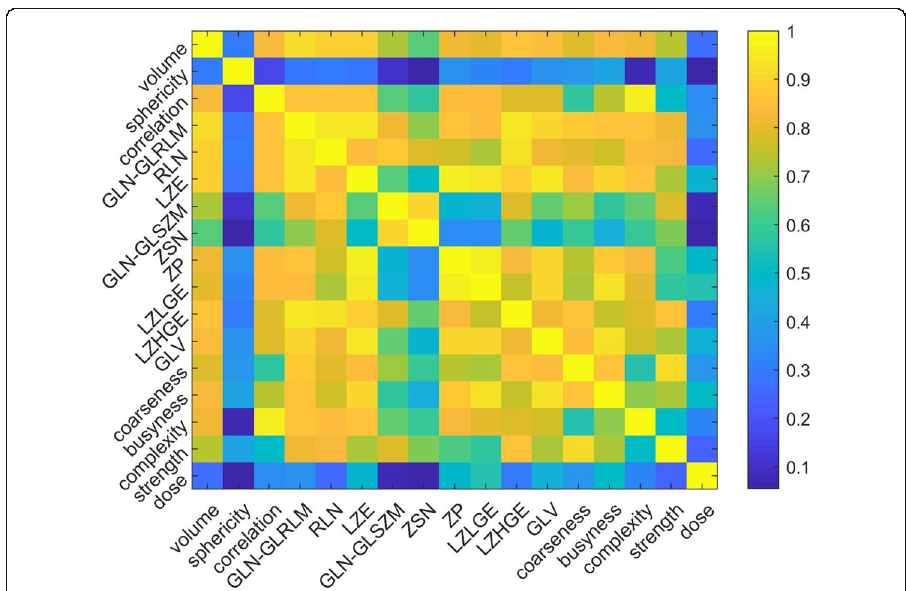
Fig. 2 Spearman correlation heat map for radiomics features, volume and absorbed dose